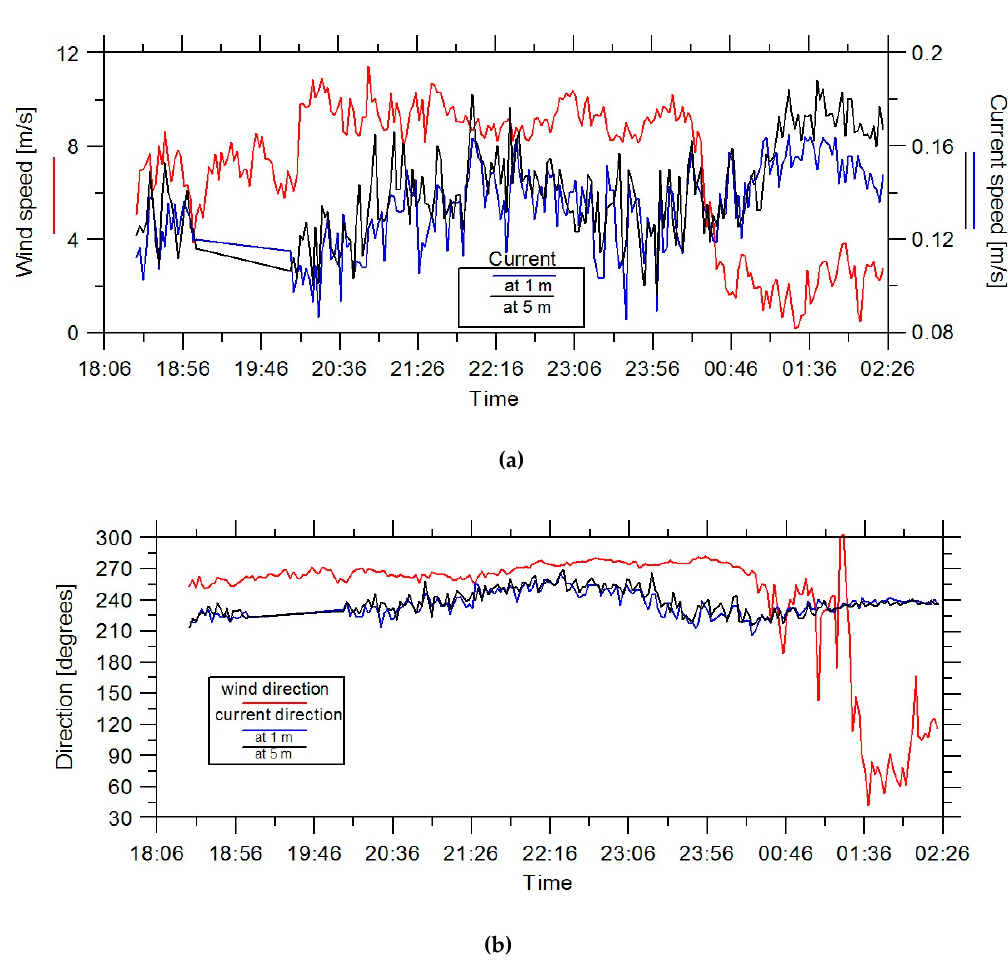
Figure 5. The measurements of: ( a ) speeds and ( b ) directions of wind and current during the experiment. The red curve is wind, black and blue show the current at depths of 1 and 5 m respectively. The direction is measured from the north direction (0 degrees).